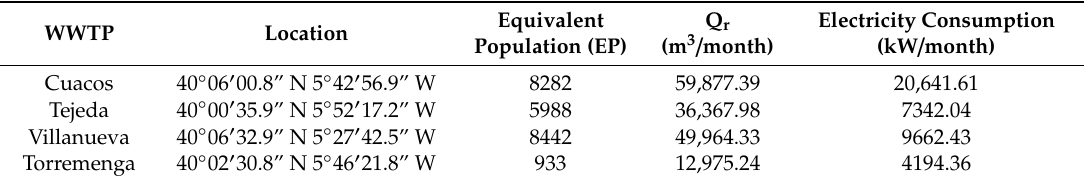
Table 2. Equivalent population (EP) and average monthly treated flow and electricity consumption of four WWTPs.